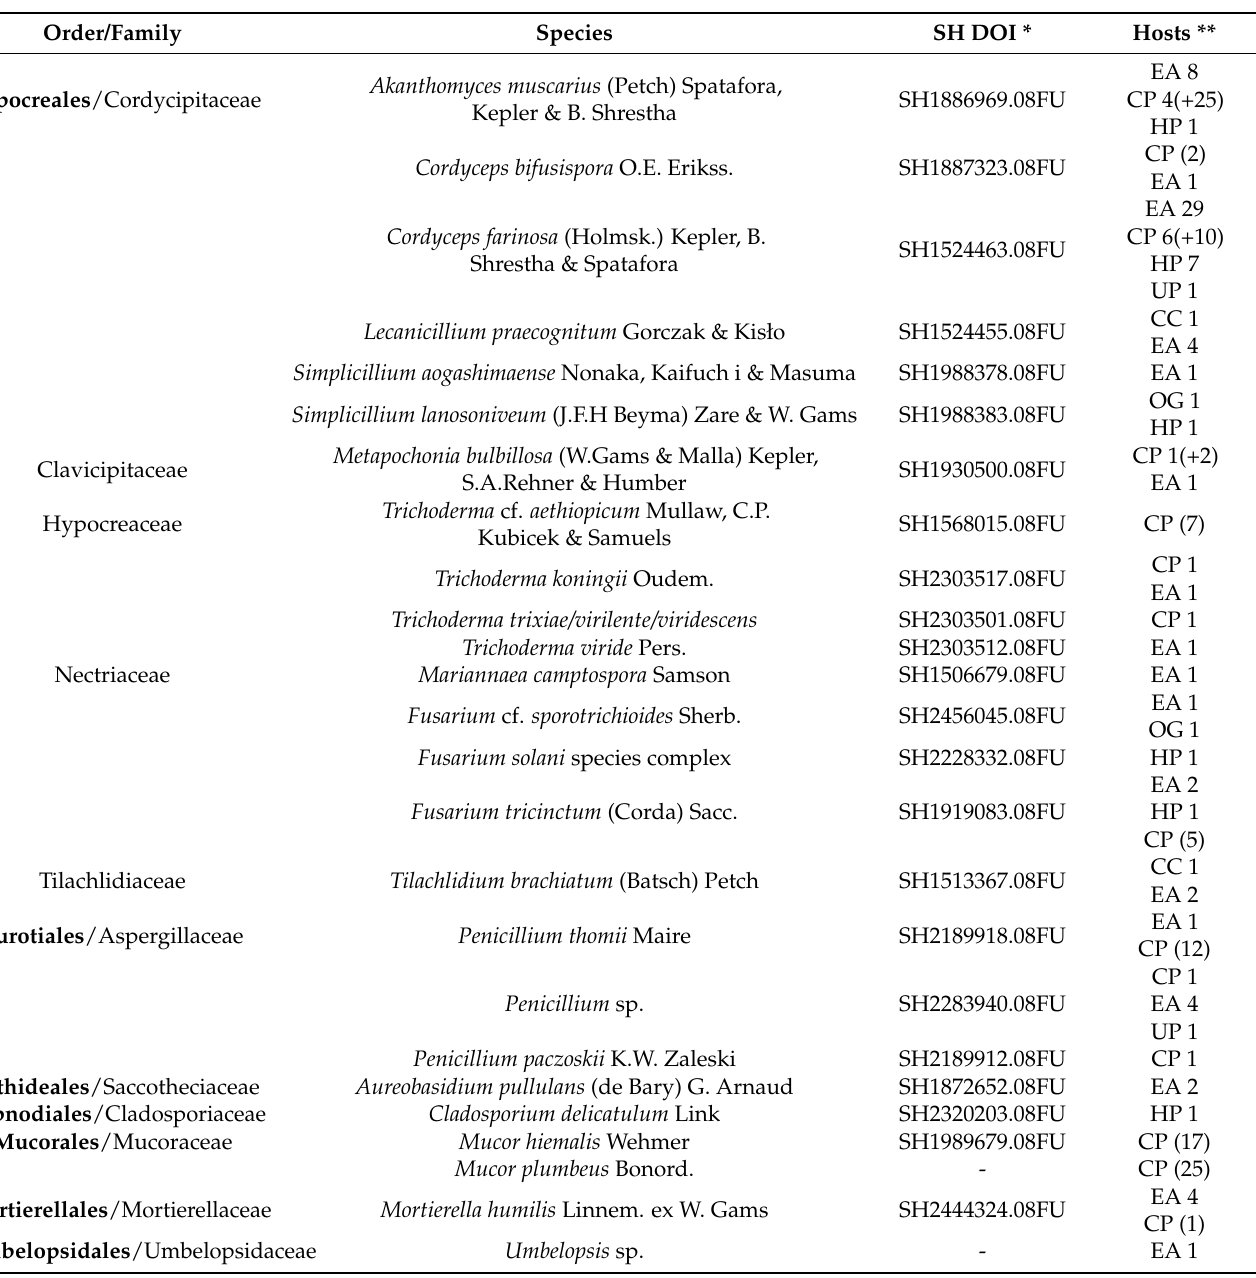
* DOI = digital object identifier, SH DOI is displayed here as a short code; ** insect hosts abbreviated as EA— Ematurga atomaria , CP— Cabera pusaria , HP— Hypomecis punctinalis , CC— Chiasmia clathrata , OP— Orthosia gothica , UP—unidentified